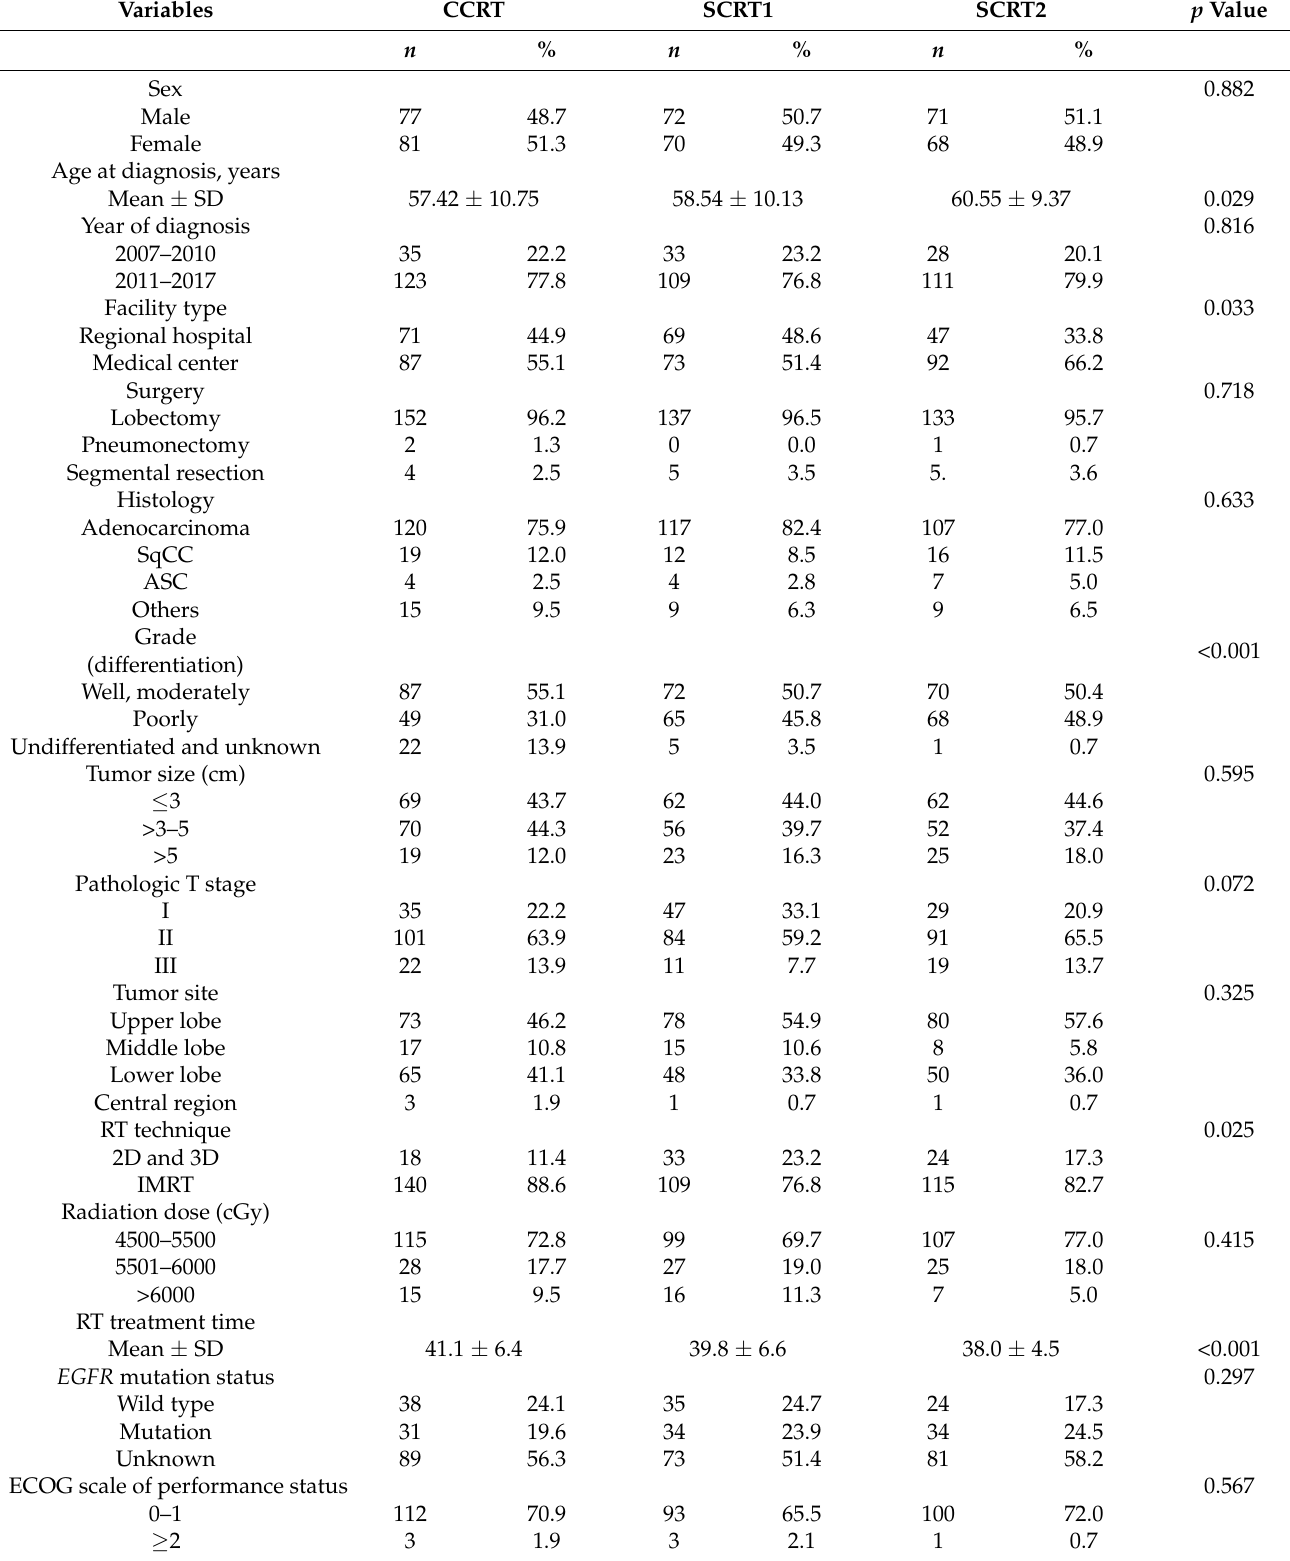
Table 1. Clinical and demographic characteristics in patients stratified by PORT schedule (CCRT, SCRT1, and SCRT2).